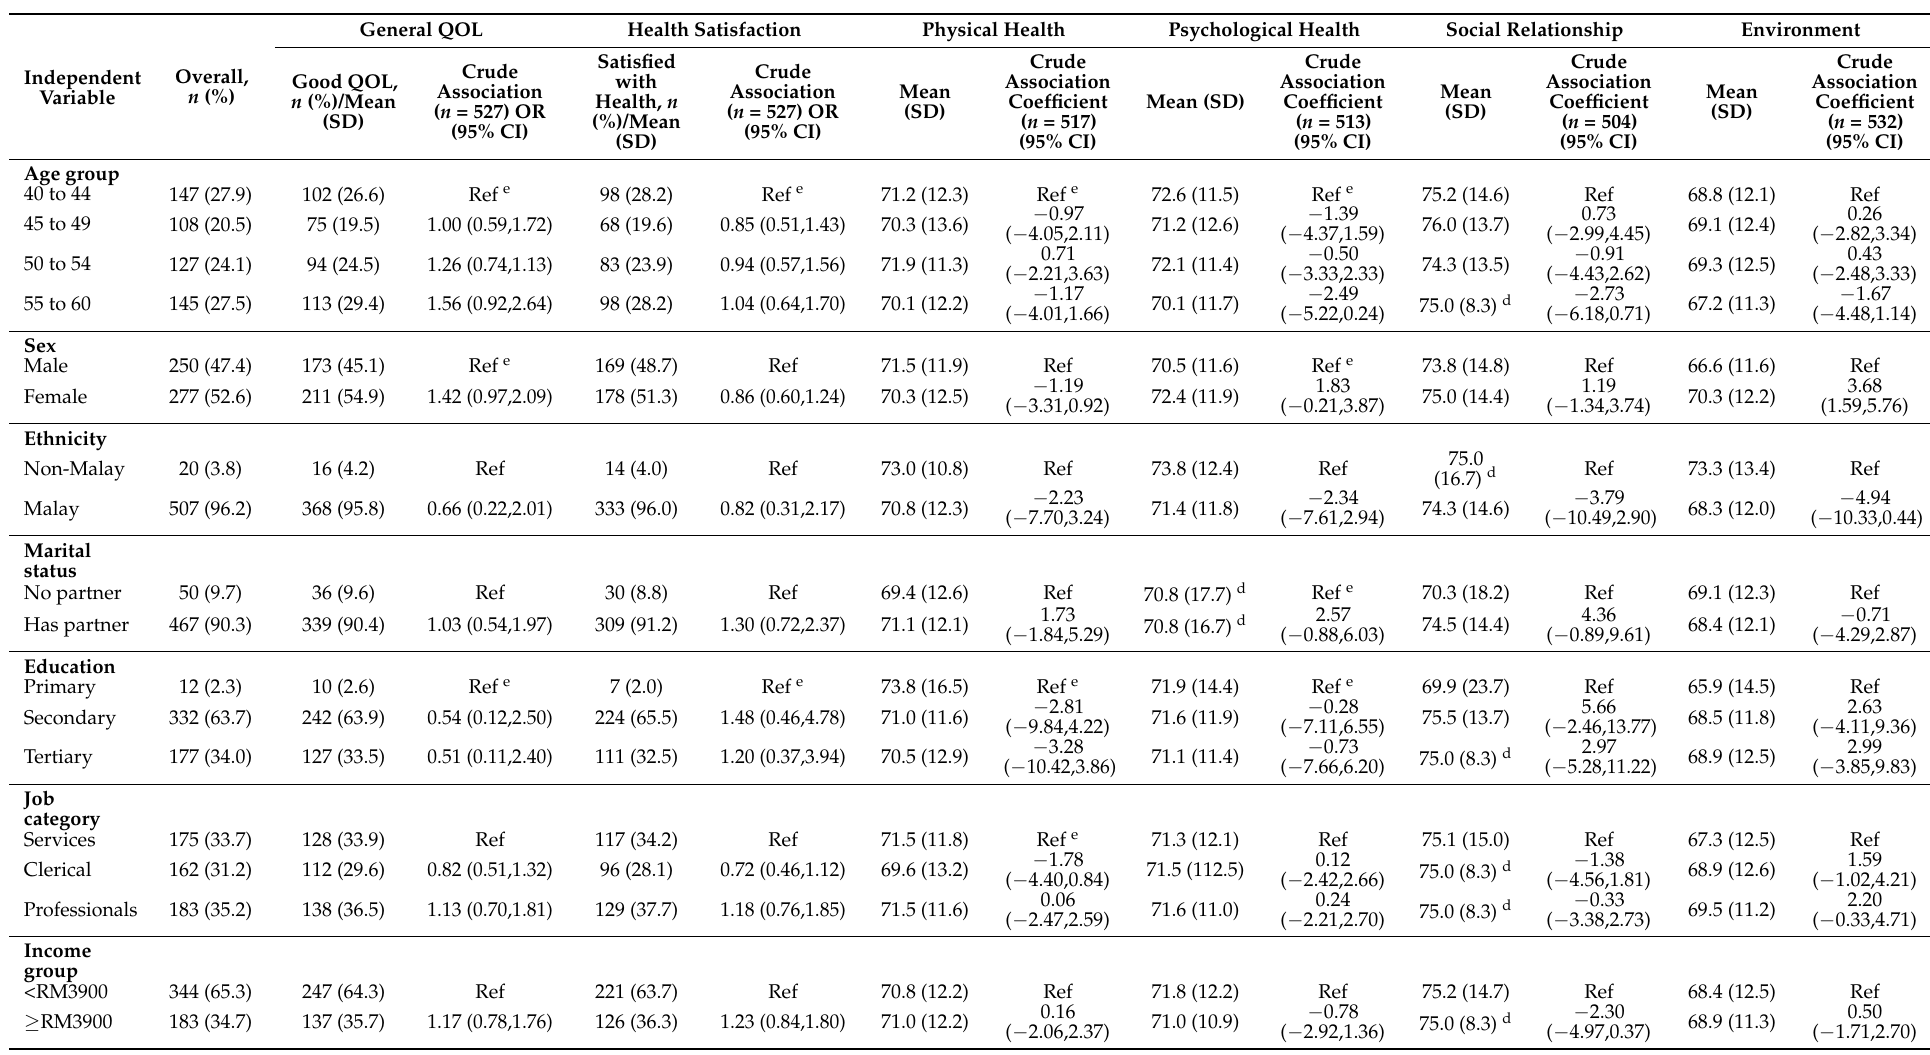
Table 2. The Association between the Independent Variables and QOL